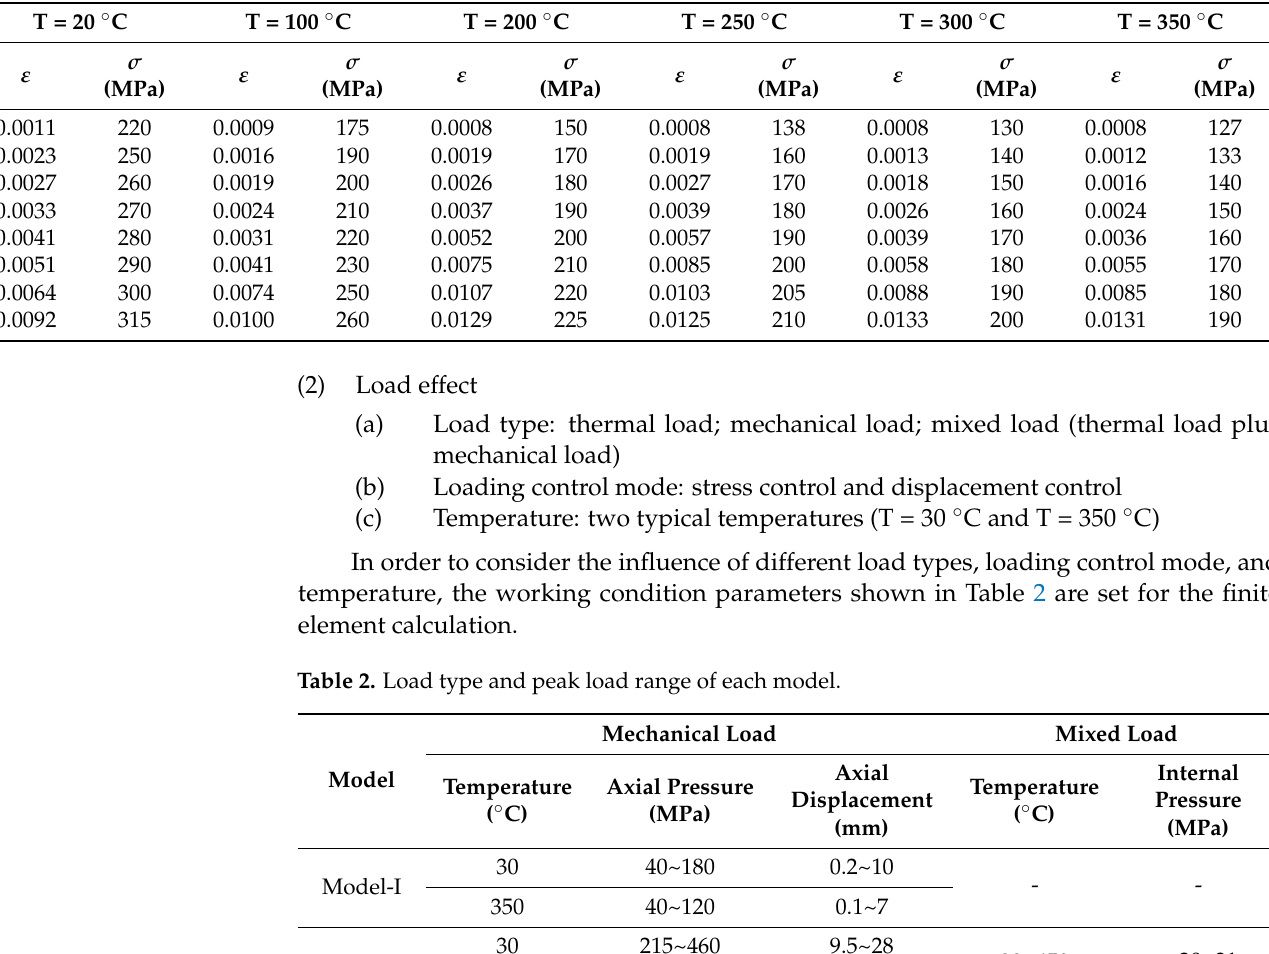
Table 1. Stress and strain relationship of Z2CND18.12 (nitrogen control) at different temperatures.